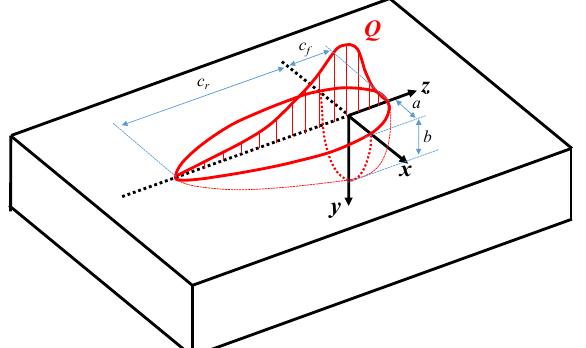
Figure 11. A Definition of geometric parameters for the heat source distribution with a double ellipsoidal shape.